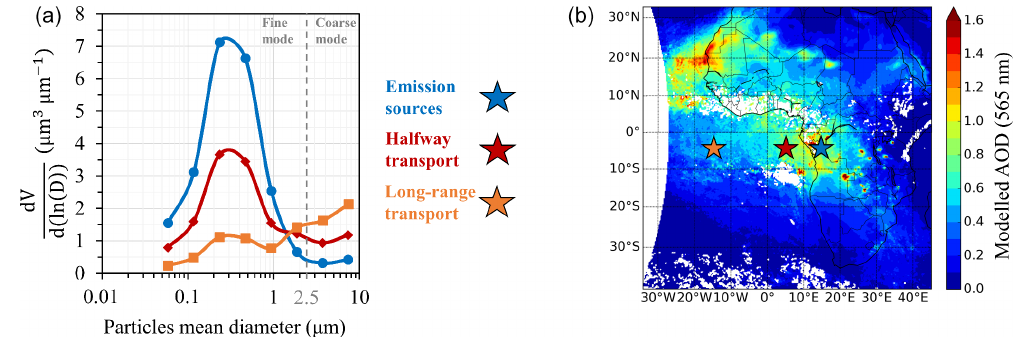
Figure 10. Evolution of the vertically integrated (whole atmospheric column) volume size distribution of aerosols (a) simulated with the WRF-Chem partially constrained configuration for three areas representative of the emission sources and transport progress of the biomass burning aerosol plume (b) on average for July 2008. The blue star corresponds to the pixel (14.83 ◦ E, 4.00 ◦ S) and symbolizes the emission sources of biomass burning particles. The red star corresponds to the pixel (4.82 ◦ E, 4.00 ◦ S) and symbolizes the biomass burning aerosol plume transported halfway westward over the southeastern Atlantic Ocean. The orange star corresponds to the pixel (14.93 ◦ W, 4.00 ◦ S) and symbolizes the long-range transport of the biomass burning aerosol plume.